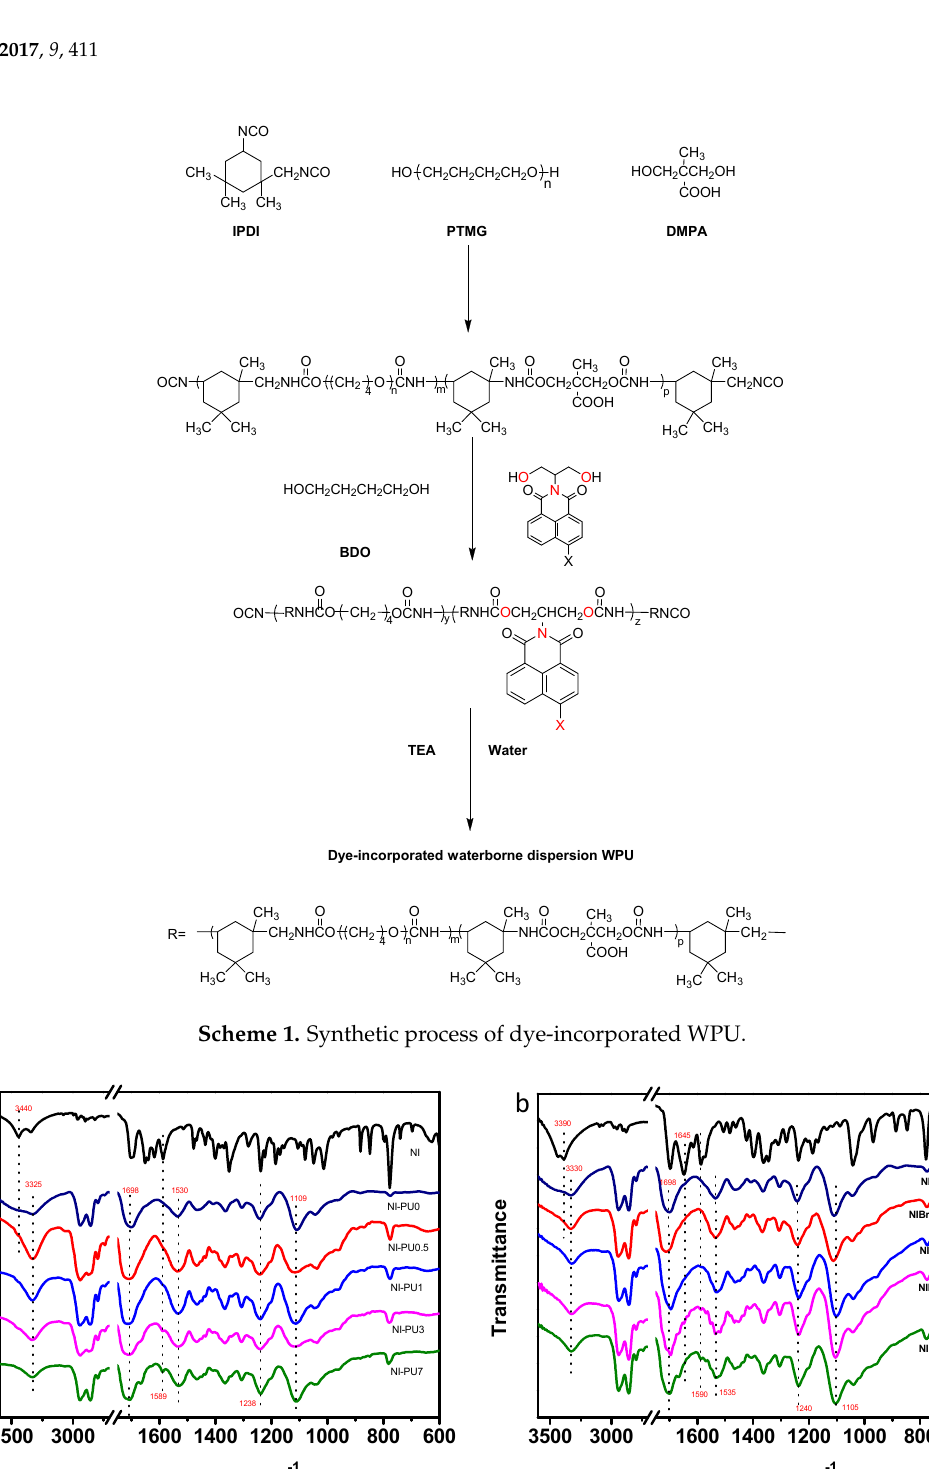
Figure 1. FTIR spectra of NI-PU ( a ) and NIBr-PU ( b ) films with different dye ratios (e.g., NI-PU1 means 1% NI by weight in WPU).